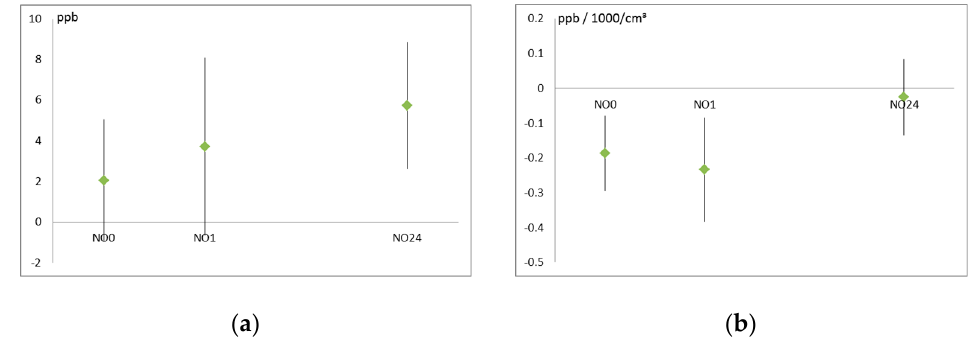
Figure 2. Effect of exposure on exhaled nitrogen oxide (NO) values (in ppb) at different time points (immediately after the walk, 1 h after the walk, and 24 h after the walk): ( a ) Exposure near the road compared to a park, controlled for background concentration; ( b ) Effect of particle number (per 1000 particles per cm 3 ) controlled for